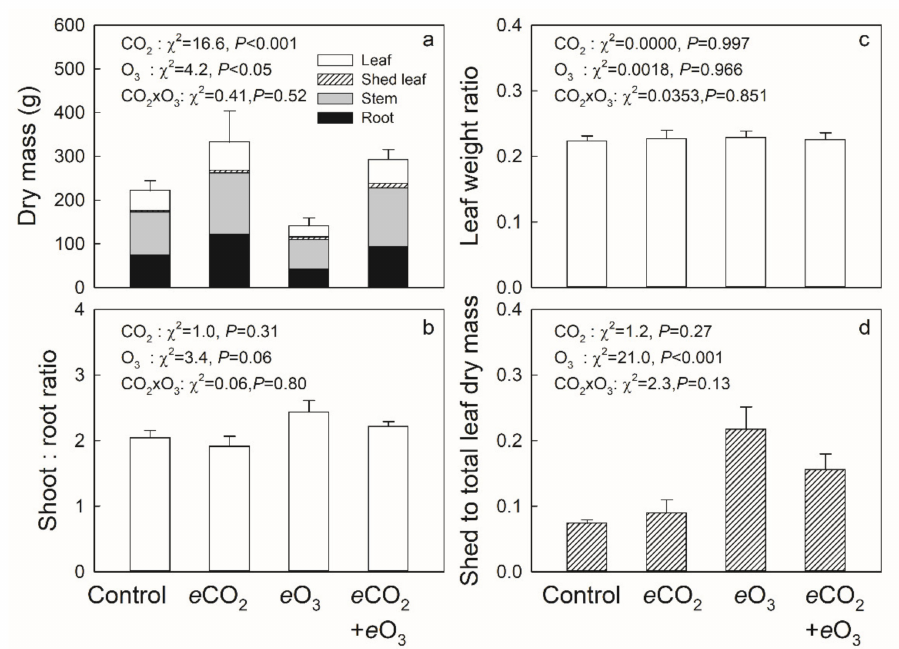
Figure 2. Dry mass of plant organs ( a ), shoot to root ratio ( b ), leaf weight ratio ( c ), and shed to total leaf dry mass ( d ) in seedlings of Japanese white birch grown under combinations of CO 2 and O 3 treatments. Seedlings were planted to the ground in the frames in March 2011, and harvested in November 2011. Enrichment of CO 2 and O 3 concentrations was conducted from May to November 2011. Shoot to root ratio is defined as [leaf + shed leaf + stem dry mass]/[root dry mass]. Leaf weight ratio = [leaf + shed leaf dry mass]/[total dry mass]. Shed to total leaf dry mass = [shed leaf dry mass]/[leaf + shed leaf dry mass]. Control—ambient air, eCO 2 —elevated CO 2 , eO 3 —elevated O 3 , and eCO 2 +eO 3 —elevated CO 2 and O 3 . Chi-square ( χ 2 ) and probability ( P ) of the effects of CO 2 , O 3 and their interaction are indicated in the panel. Values are mean + SE ( n =